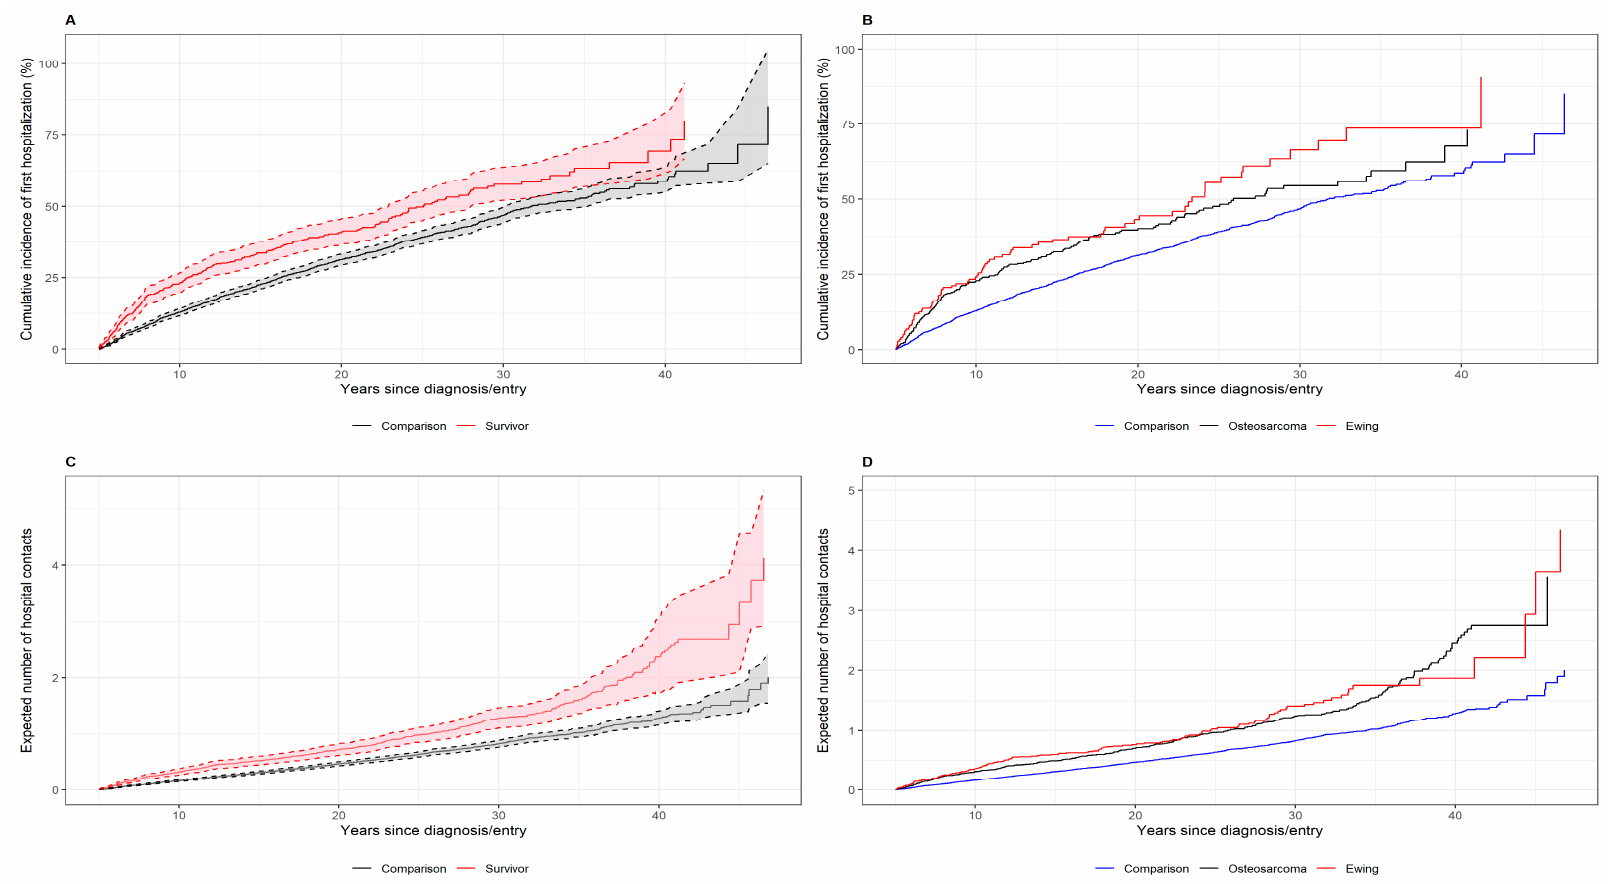
Figure 4. Cumulative incidence of first hospital contact and 95% confidence intervals (CIs) by time since diagnosis or entry for survivors and comparisons (panels A and B ). Expected numbers of hospital contacts (mean cumulative count) with 95% CI for survivors and their matched comparisons by time since diagnosis or entry (panels C and D ).